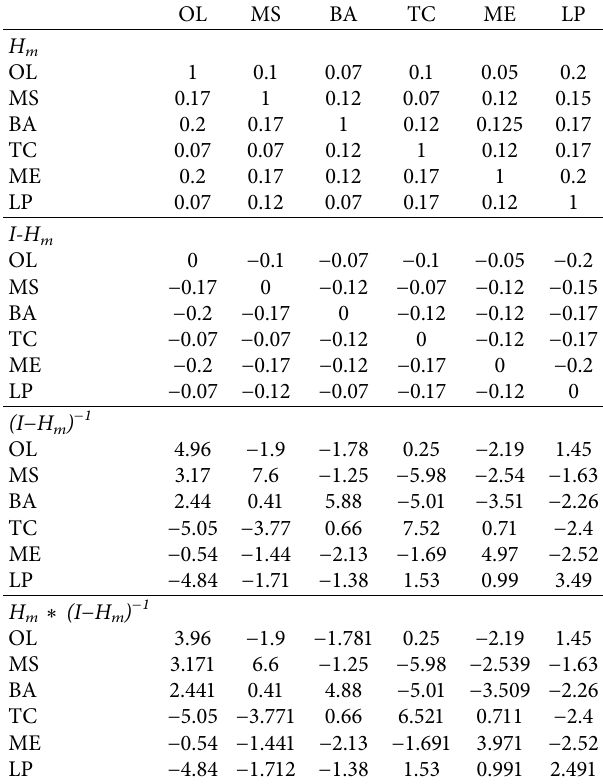
Table 6: Generation of the l matrix of general relationships for activities.